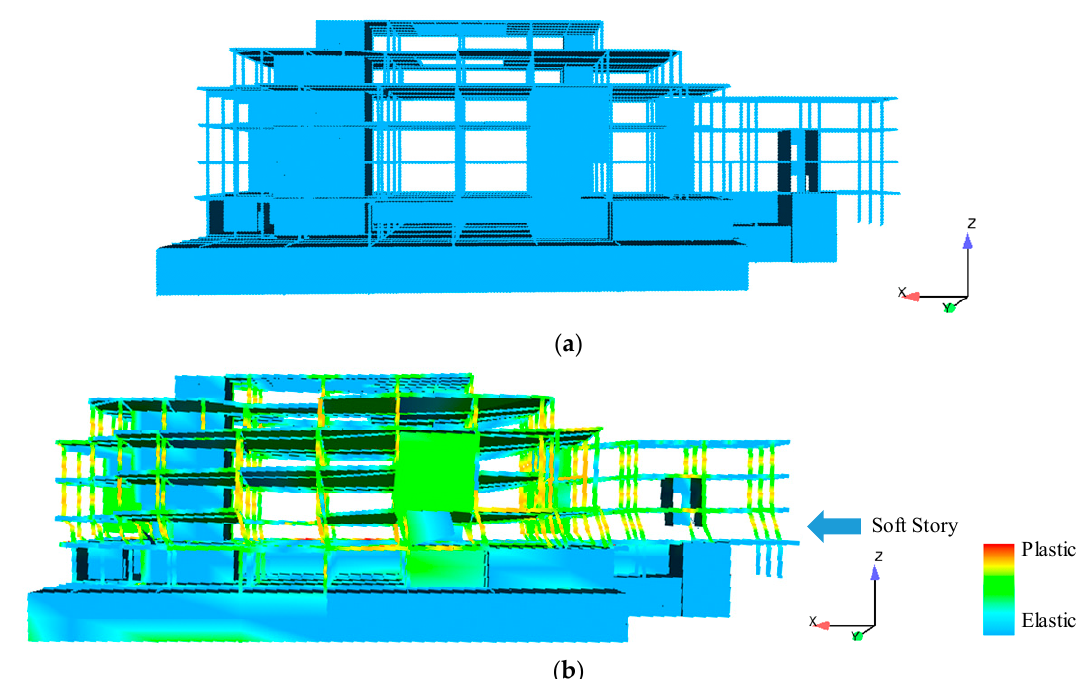
Figure 12. FE model and simulation results of the library building: ( a ) FE model of the library building; ( b ) simulation results ( t = 1.76 s).